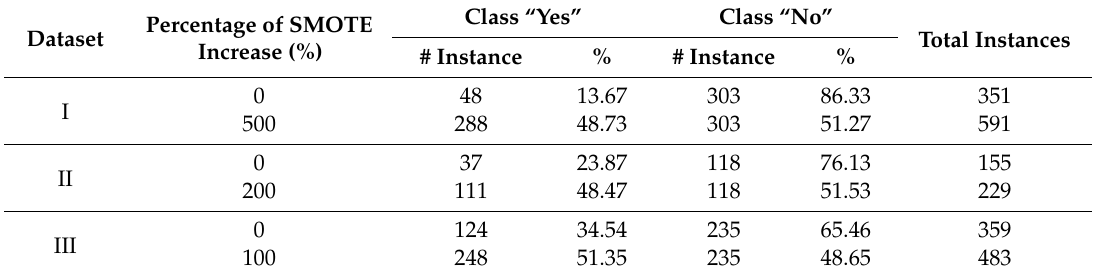
Table 5. Number of instances increase by Synthetic Minority Over Sampling Technique (SMOTE).